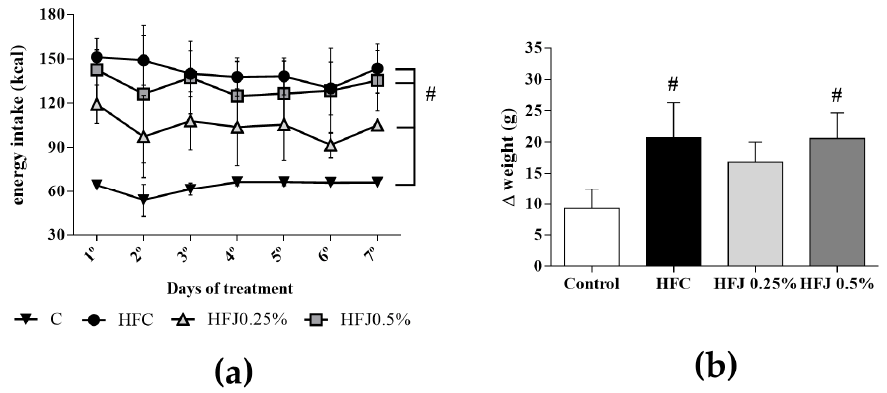
Figure 1. ( a ) Mean daily energy intake estimative during the experiment; ( b ) body weight gain ( Δ ). # p < 0.05 compared with the control diet (C) group ( n = 6 or 7). Table 1. Relative tissue weight among different experimental groups.